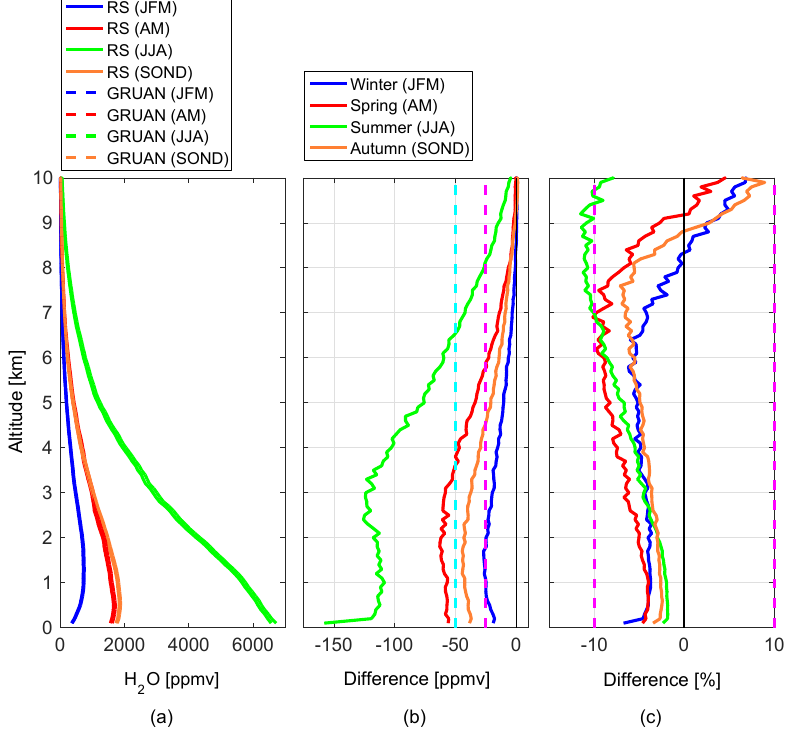
Figure 7. (a) Coincident radiosonde (RS) and GRUAN profiles by season. (b) Differences between the profiles. (c) Percent differences. ( X is RS and Y is GRUAN in Eqs. 1 and